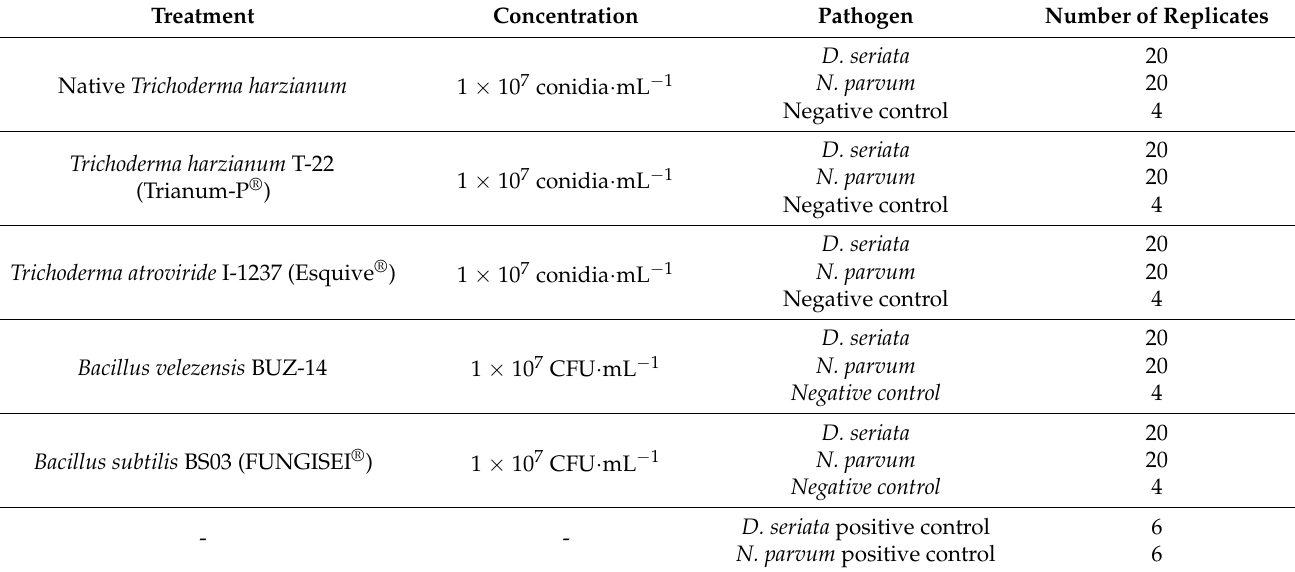
Table 1. Treatments, concentrations, and replicates used in the